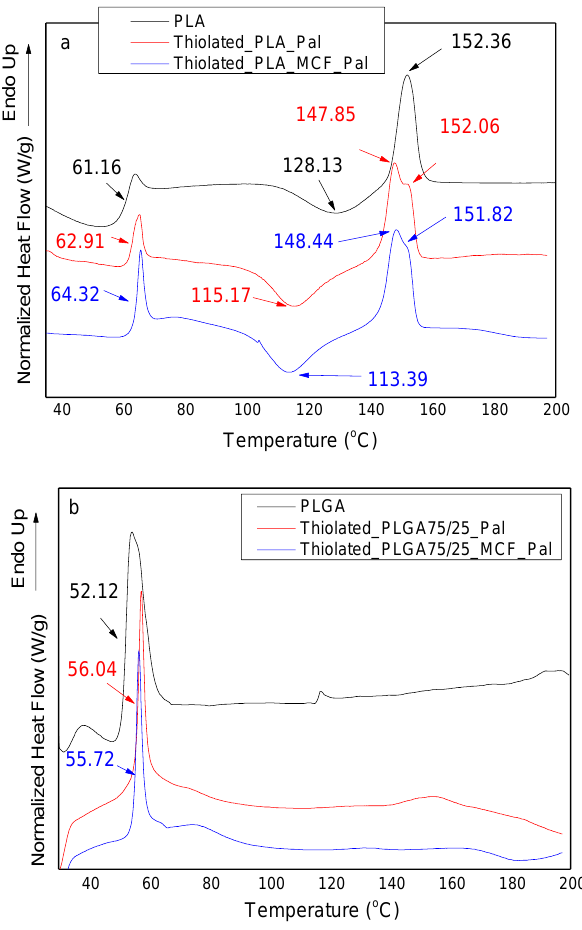
Figure 9. DSC thermograms of thiolated chitosan coated microspheres consisted from ( a ) PLA and ( b ) PLGA with encapsulated paliperidone and MCF_paliperidone.